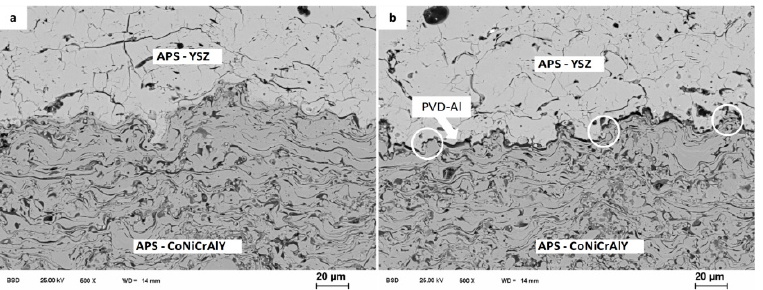
Figure 2. Backscattered scanning electron microscope images (BSD-SEM) presenting the as-sprayed coatings: ( a ) R-TBC and ( b ) Al-TBC. coatings: ( a ) R-TBC and ( b )